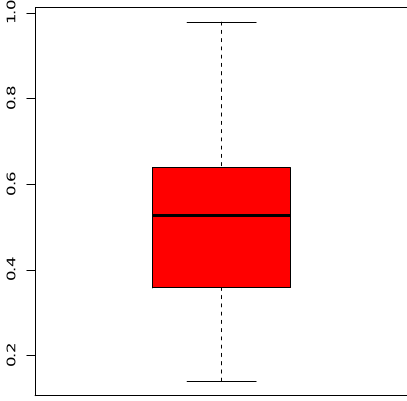
Figure 5. Boxplot for the trade share data set.